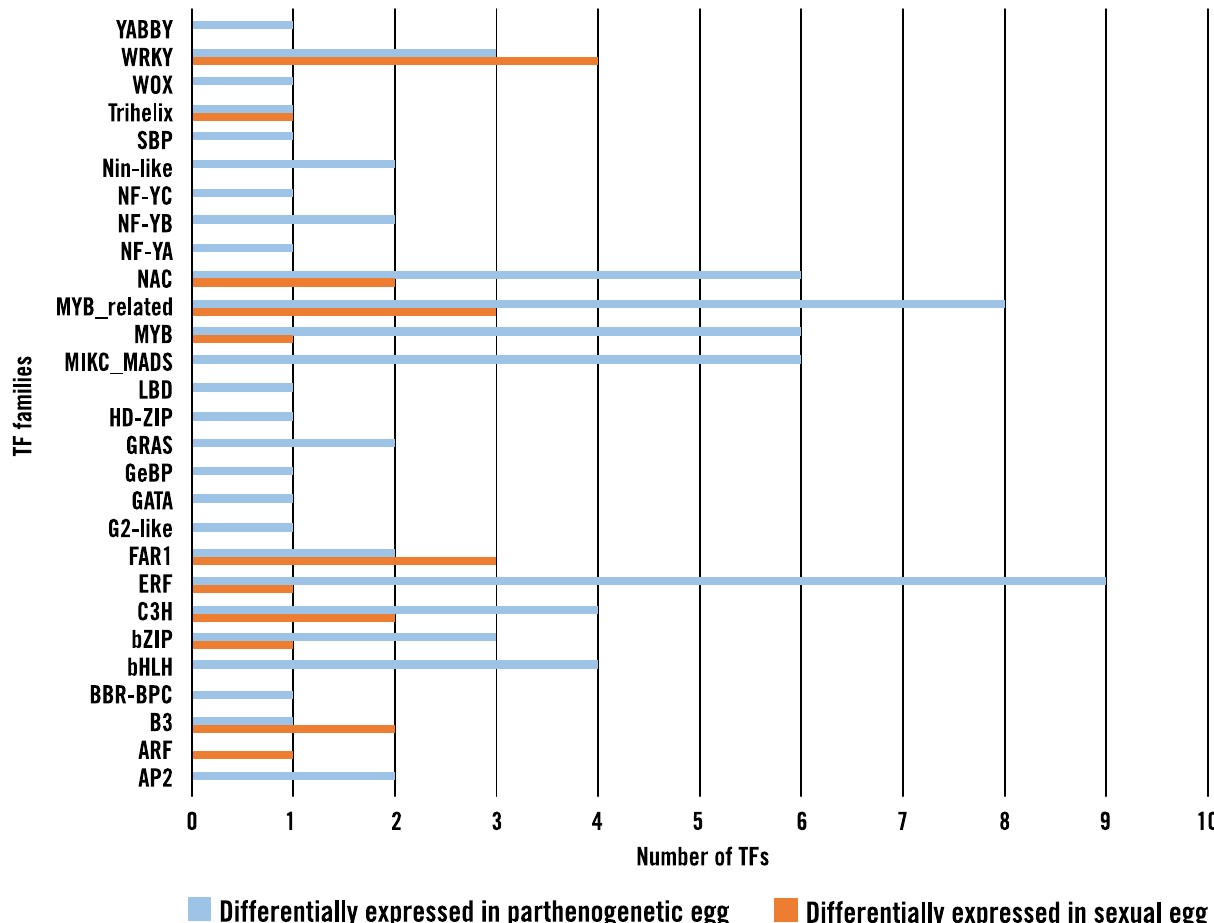
Figure 7. De novo expressed transcription factor families between sexual and parthenogenetic